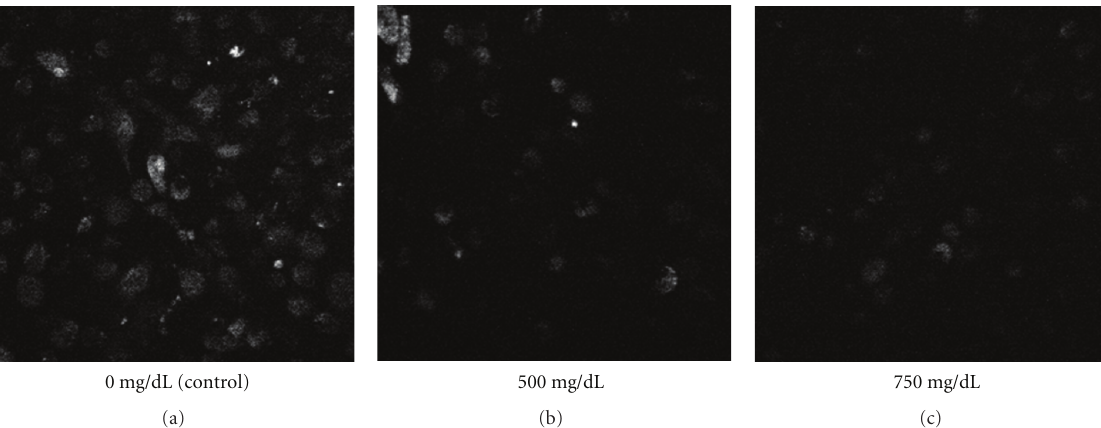
Figure 3: Confocal images of HPT cells in 24 well plates treated with FL-MTX (4 μ M) and di ff erent concentrations of ethanol (0, 500, and 750mg/dL). The images reveal that ethanol concentration has an impact on FL-MTX uptake.